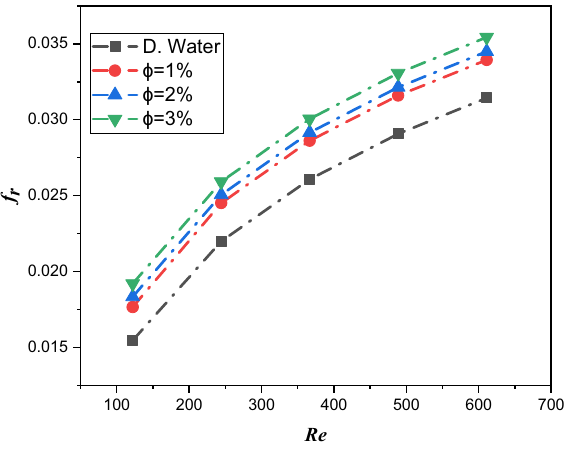
Figure 17. Estimation of the friction factor against the Reynolds number in a microchannel heat sink with TiO 2 /water nanofluids and distilled water.